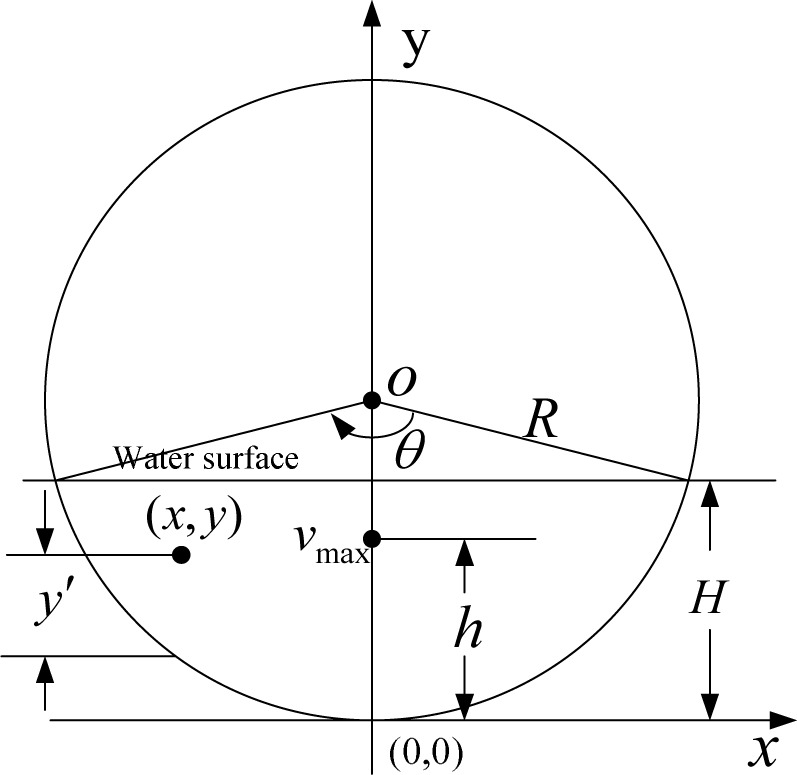
Schematic of Rectangular Coordinate System